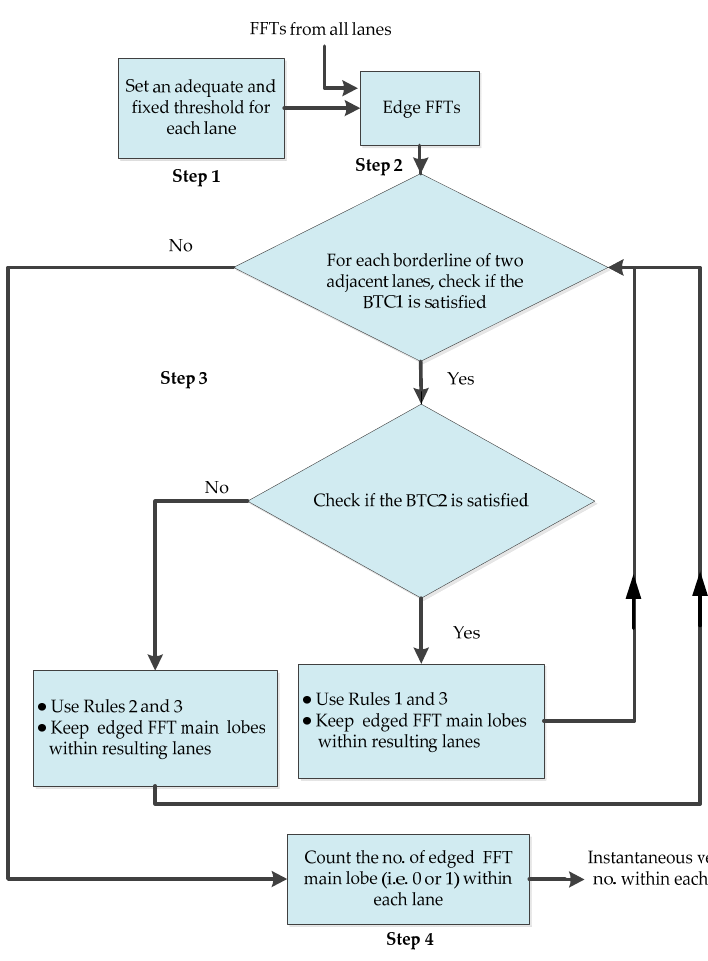
Figure 7. Functional procedure of the proposed method 2.